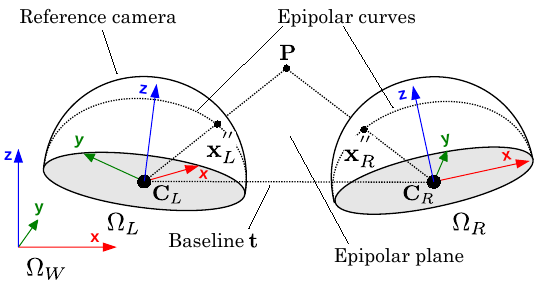
Figure 3. The two hemispheric cameras are located at C L and C R with independent orientation in the world coordinate system (cid:127) W .